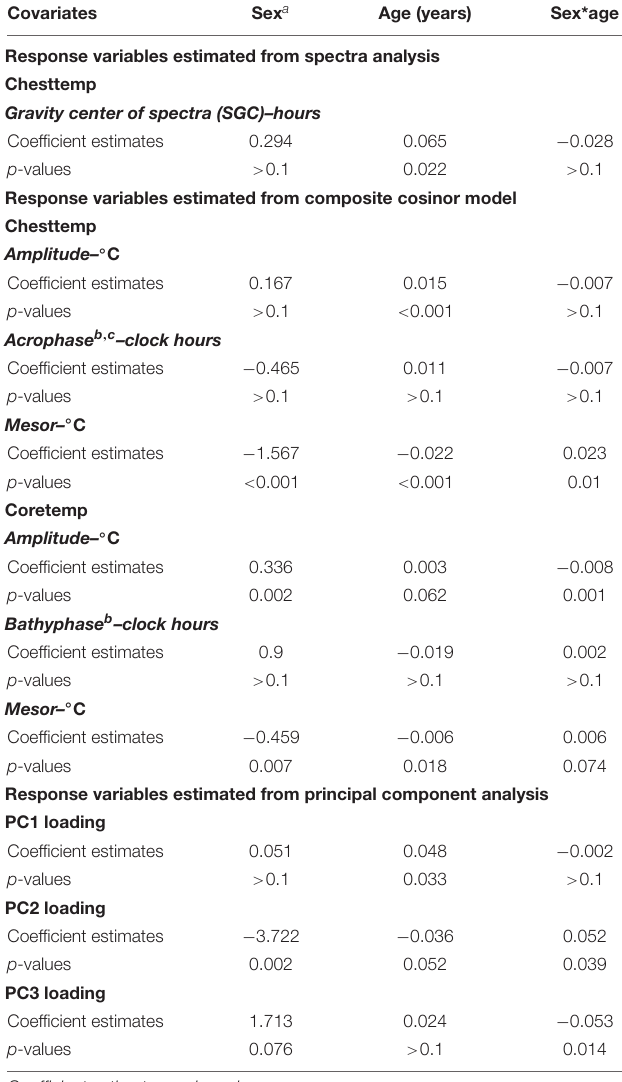
TABLE 3 | Multivariate regression